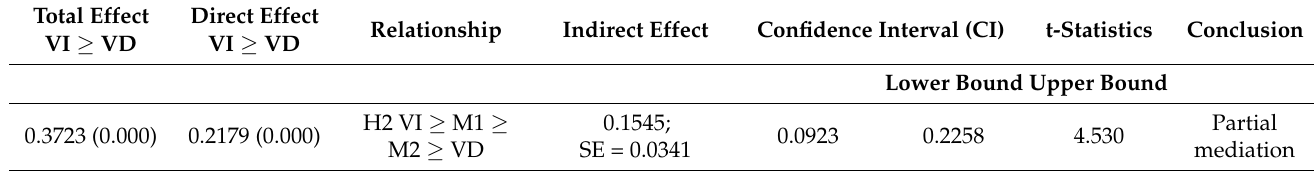
Table 12. Mediation effects